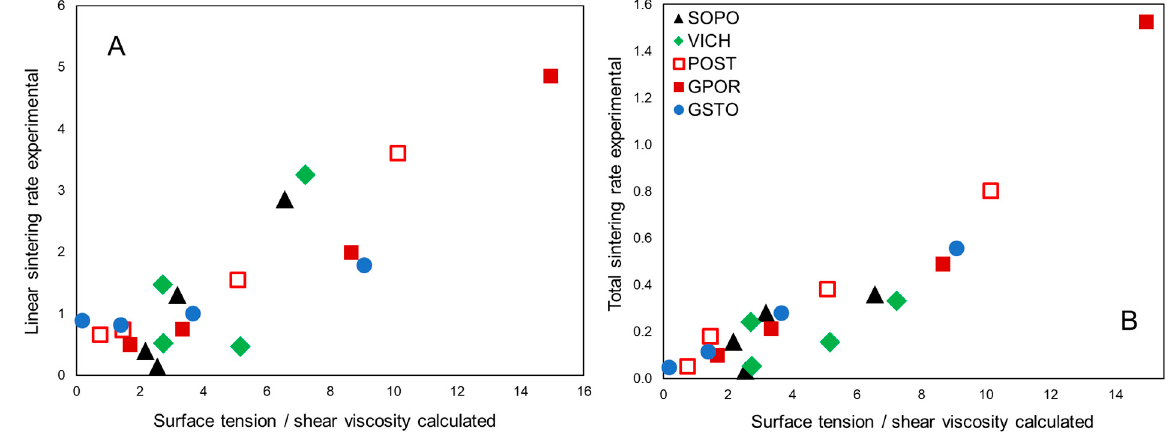
Figure 15. Sintering ratio vs. experimental sintering linear rates ( A ) and vs. experimental sintering total rates ( B ). Experimental uncertainty is within the symbol size.